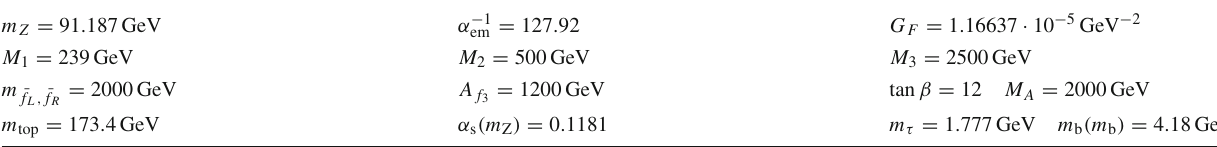
Table 1 Fixed SM and SUSY input parameters of the NMSSM scenario. Thegauginomassparametersaredenotedas M i with i = 1 , 2 , 3andthe ratio of the electroweak vevs tan β . We have the trilinear soft-breaking